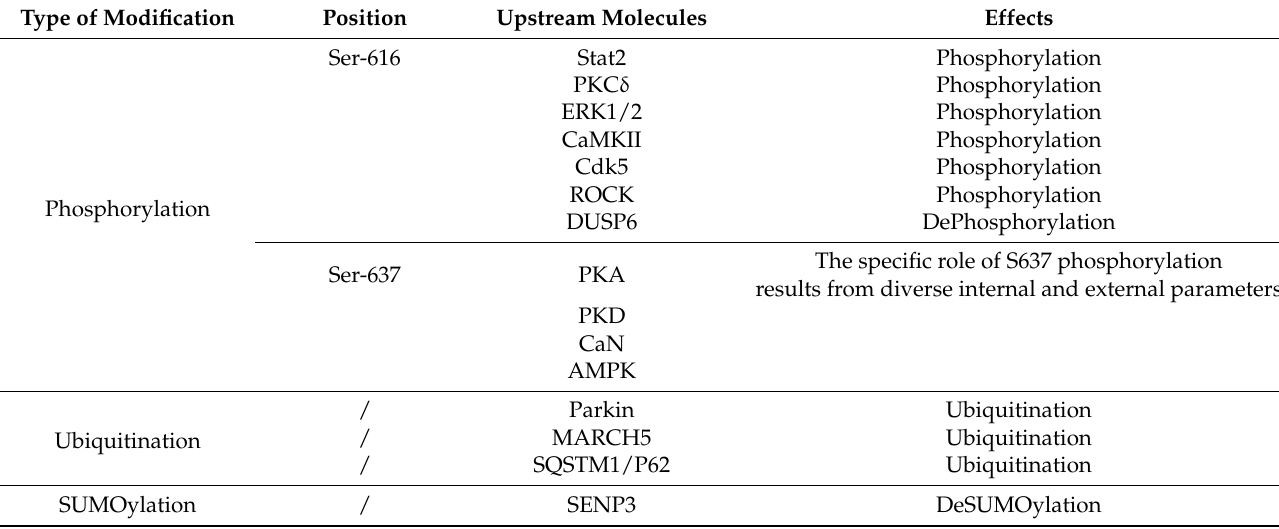
Table 2. Post-translational modifications of